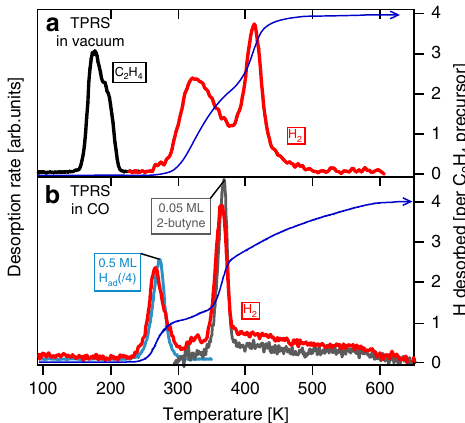
Fig. 2 Temperature-programmed reaction spectroscopy. Ethylene (black line) and hydrogen desorption (red line) during heating (0.2 K s − 1 ) of a an ethylene-saturated Co(0001) in vacuum and b a 0.12 ML C 2 H 2ad /0.24 ML H ad -covered surface in 1 × 10 − 7 mbar CO. H 2 desorption from a 0.5 ML H ad -covered surface heated in CO (light blue and divided by 4 to facilitate comparison) and H 2 desorption due to 2-butyne decomposition (grey line, in 1 × 10 − 7 mbar CO) are added for reference. The dark blue lines show the integral of the H 2 desorption traces in the absence and presence of CO, normalized to the number of H atoms in the ethylene Fig. 2b. The peak around 270 K is attributed to desorption of surface-bound hydrogen, shifted downward due to the presence of CO 30 – 32 . The peak area indicates that 0.12 ML H ad desorbs around 270 K, only 50% of the 0.24 ML H ad that was present prior to CO exposure. This is explained by acetylene hydrogena- tion to ethylidyne (HC ≡ CH + H ad → ≡ C-CH 3 ), a reaction that